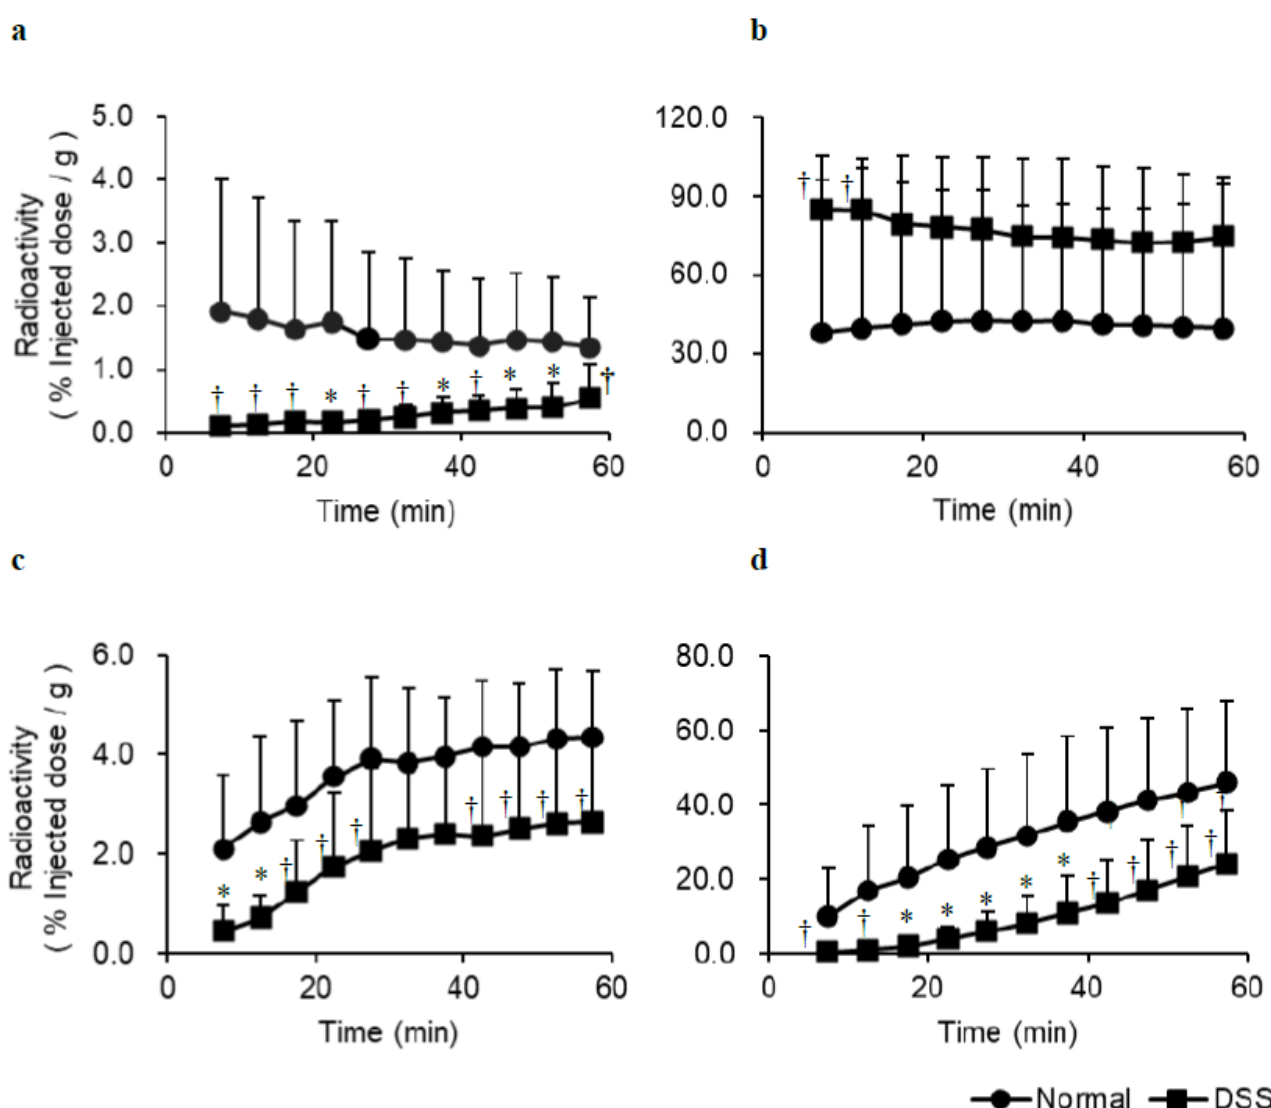
Figure 3. Time activity curves for the heart ( a ), stomach ( b ), liver ( c ), and bladder ( d ) in SPECT images of control and DSS-induced experimental colitis mice orally injected with [ 123 I]MIBG. In DSS-induced experimental colitis mice, accumulation of [ 123 I]MIBG is significantly lower in the heart, liver, and bladder than in normal mice, whereas accumulation is higher in the stomach in the early time points after oral [ 123 I]MIBG administration. * p < 0.01 and † p < 0.05 between normal and DSS model mice.